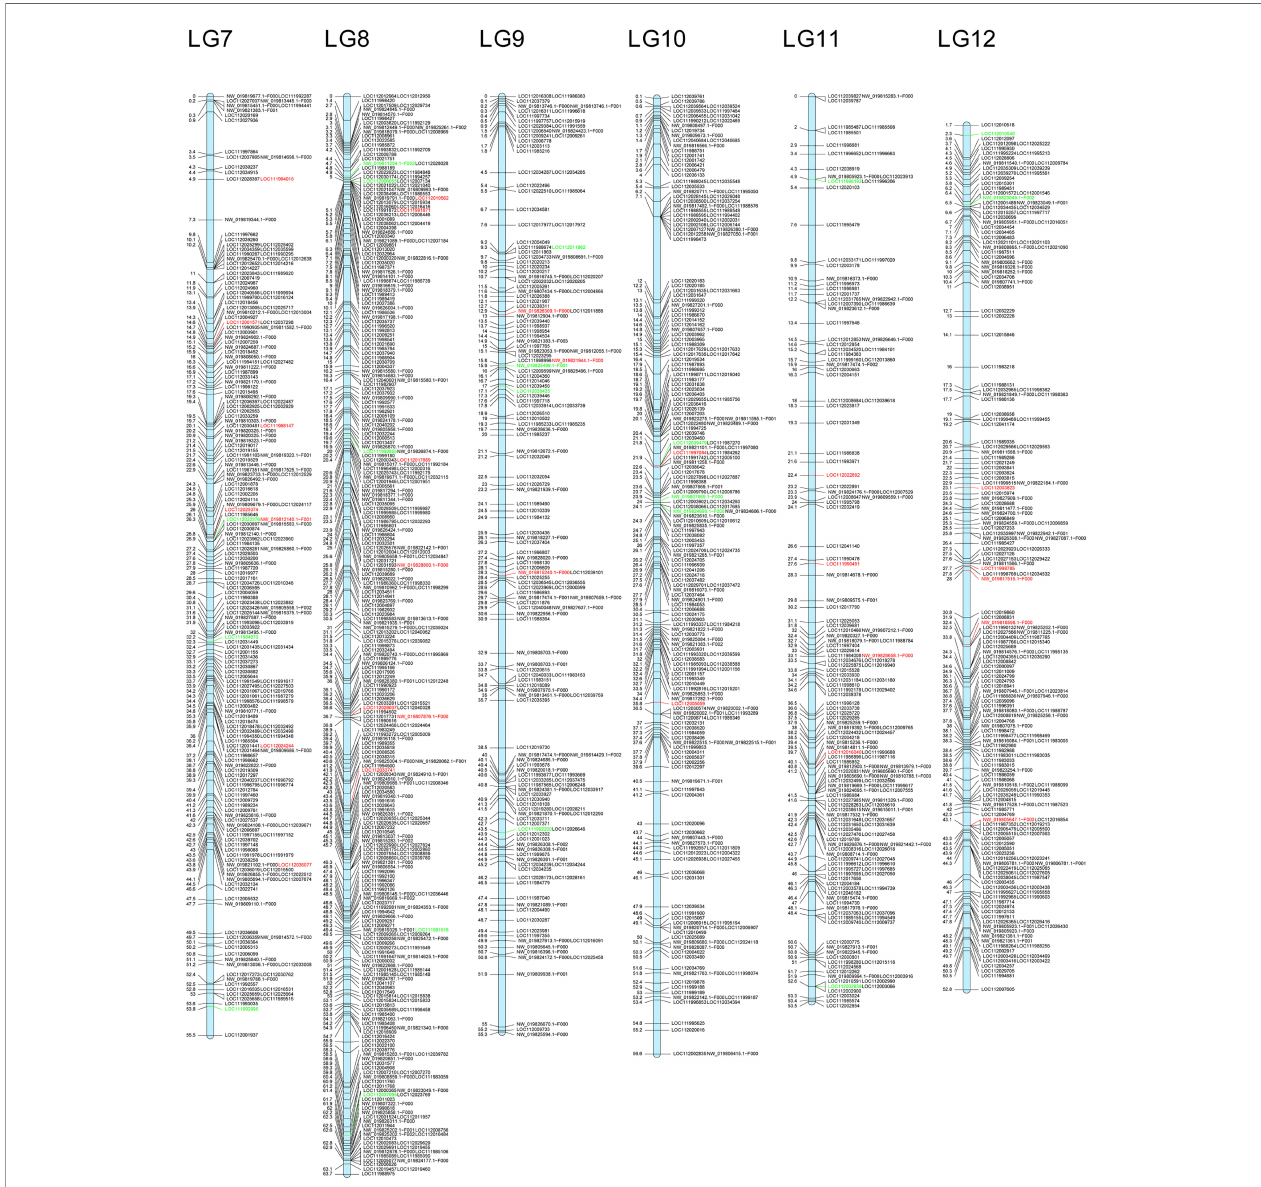
FIGURE 5 | Putative location in the Q. robur linkage groups of the genomic fragments including markers from ScnI. Location of markers with allelic frequencies in the adult hybrids very similar to one of the parental species is highlighted in red ( Q. ilex ) or in green ( Q. suber